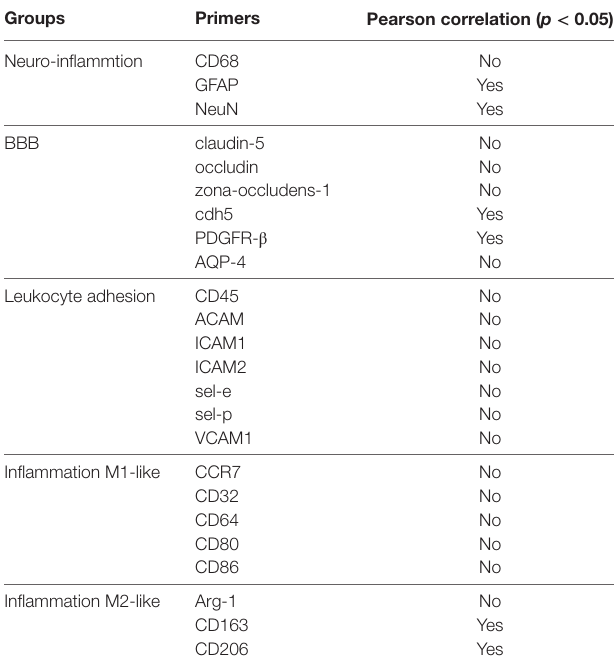
Table 1 | Overview of significant Pearson correlation at 14 weeks for (A) neuroinflammation markers, (B) blood–brain barrier (BBB) markers, (C) leukocyte infiltration markers, and (D) inflammation